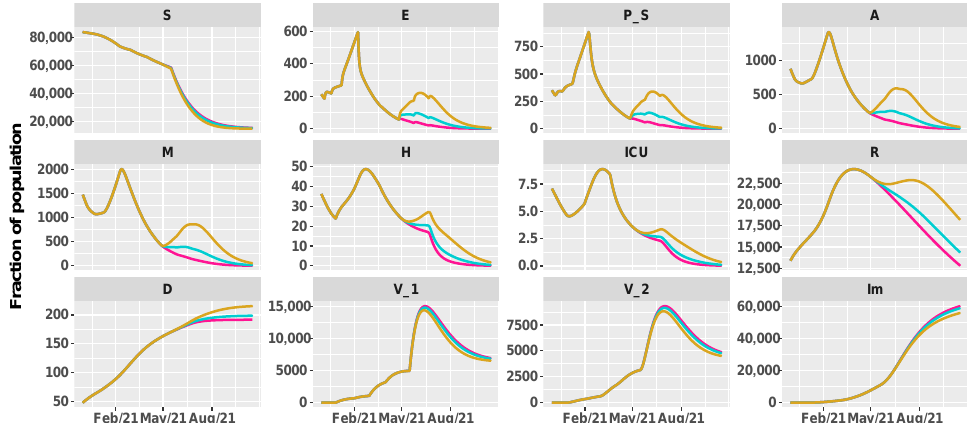
Figure 7. Projections of the epidemic evolution with a vaccination schedule of 18,000 first doses of vaccines per day in Umbria (fast vaccination). Each line corresponds to a different reopening strategy, i.e., different values of transmission rate parameters b e and b 0 (yellow for high values, blue for medium values, and pink for low values).